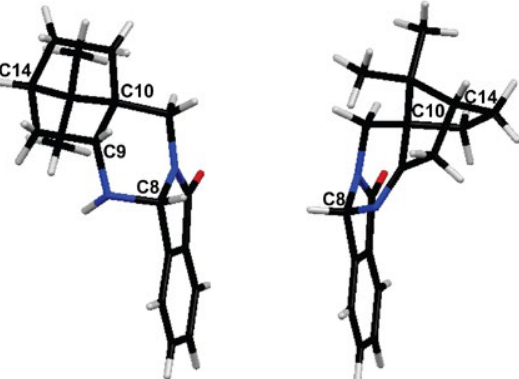
Figure 4. Mercury 29 drawing of compounds 6 (on left) and 7 (on right) with labelling of chiral carbon centers of the phthalimide part of the molecule.